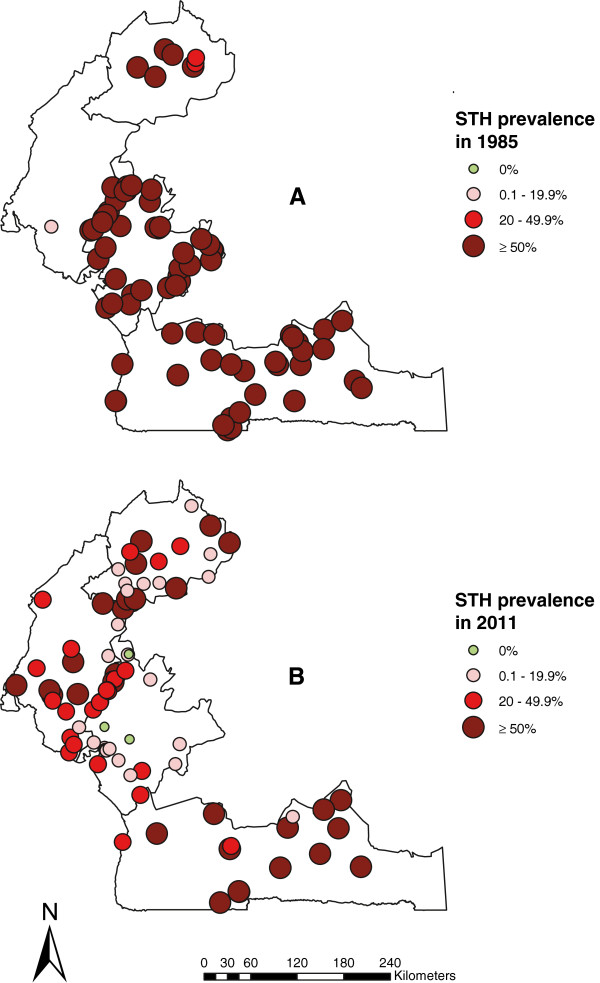
Comparative maps of the overall soil-transmitted helminthiasis prevalence in the four surveyed regions of Cameroon. Prevalence distribution in 1985–1987 (A) and in 2011 (B).